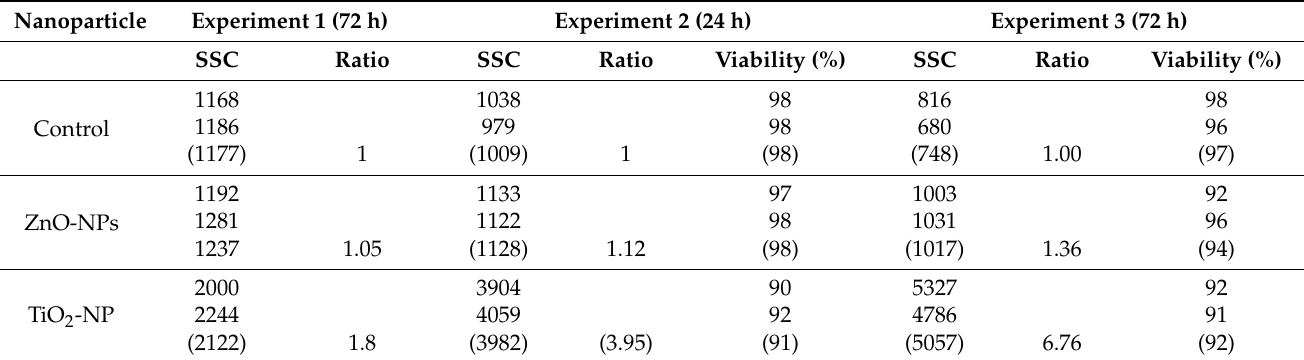
Table 2. Mean side scatter (SSC) and viability of the cell cultures exposed to NPs. Cells were exposed to 20 µ g/mL of TiO 2 -NPs or 5 µ g/mL of ZnO-NPs, as described in Section 4.4. Then, they were treated as described in Section 4.6 for flow cytometry. Two biological replicates were used for each experiment. Here we see the individual records of the biological replicates and their respective means (in brackets). Viability was determined using propidium iodide only in the second experiment. Ratios were estimated with the means as the SSC sample/SSC control. These experiments were run in parallel to the silver NPs and shared controls with the data published in [15].